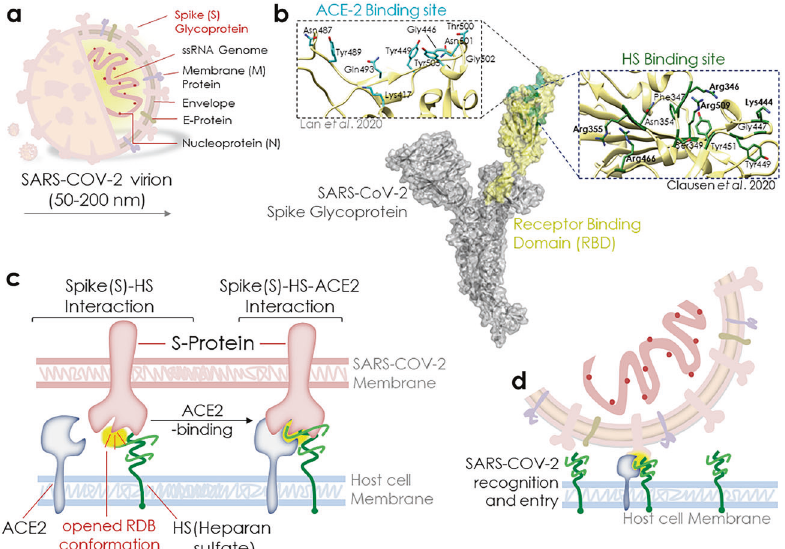
Fig. 1 Heparan sulfate enhances SARS-CoV-2 spike protein binding to ACE2 and potentiates viral infection. a SARS-CoV-2 virion and spike (S) glycoprotein. b A 1273-amino acid-long SARS-CoV-2 S glycoprotein. Receptor-binding domain (RBD) that interacts with the host cell surface ACE2 receptor is exhibited here in yellow. A network of hydrophilic (13H bonds and two salt bridges — shown in cyan) interactions contribute to this binding of ACE2 to RBD (Lan et al. 2020), whereas a putative HS-binding site is shown just adjacent to the ACE2-binding site in RBD. The key residues suggested to involve in the interaction are shown in green on the right of RBD. c . Schematic diagram showing HS-led open conformation of RBD and subsequent spike(S)-HS-ACE2 interaction. d Schematic model depicting SARS-COV-2 recognition and